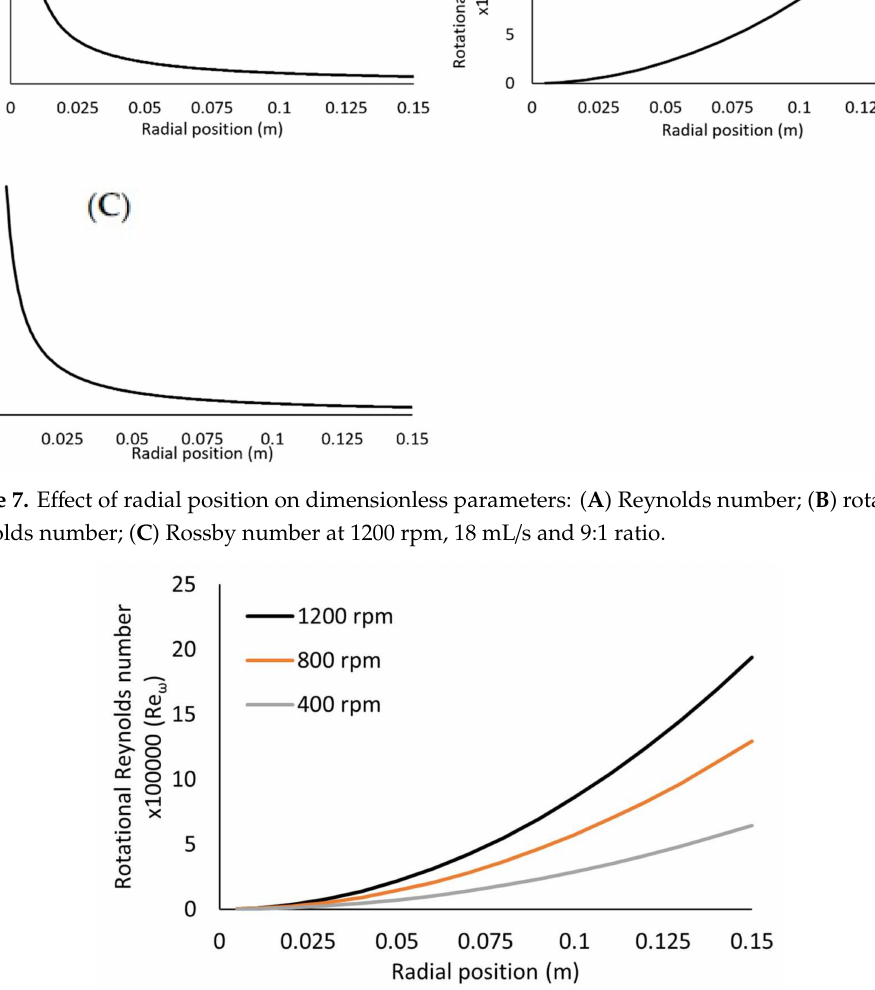
Figure 8. E ff ect of radial position on rotational Reynolds number at various disc speeds and 18 mL / s and 9:1